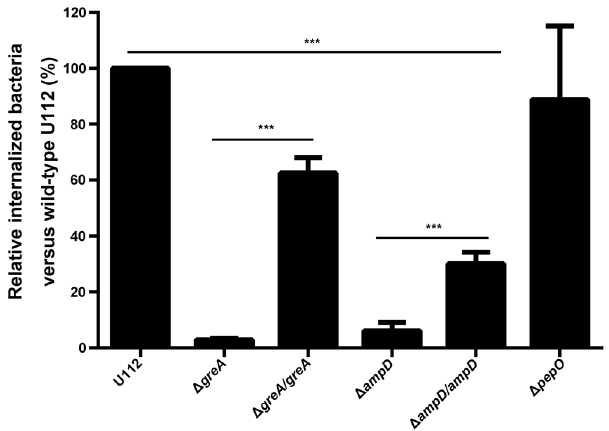
Figure 7. Impact of deletion of ampD and pepO on invasion of cells by F. novicida in vitro . RAW264.7 cells were infected with the wild-type U112 strain or its derivatives at an MOI of 100:1 for 2 h. After treatment with 100 μ g/ml gentamycin for 1 h, the infected cells were lysed and spread on TSA plates for enumeration. The values are mean percent of internalized bacteria relative to the wild-type U112 strain ± SD of the results from triplicate samples as compared with those of the wild-type U112 strain. The experiment was repeated twice. Statistical significance was determined by one-way analysis of variance (ANOVA) test. *** p <